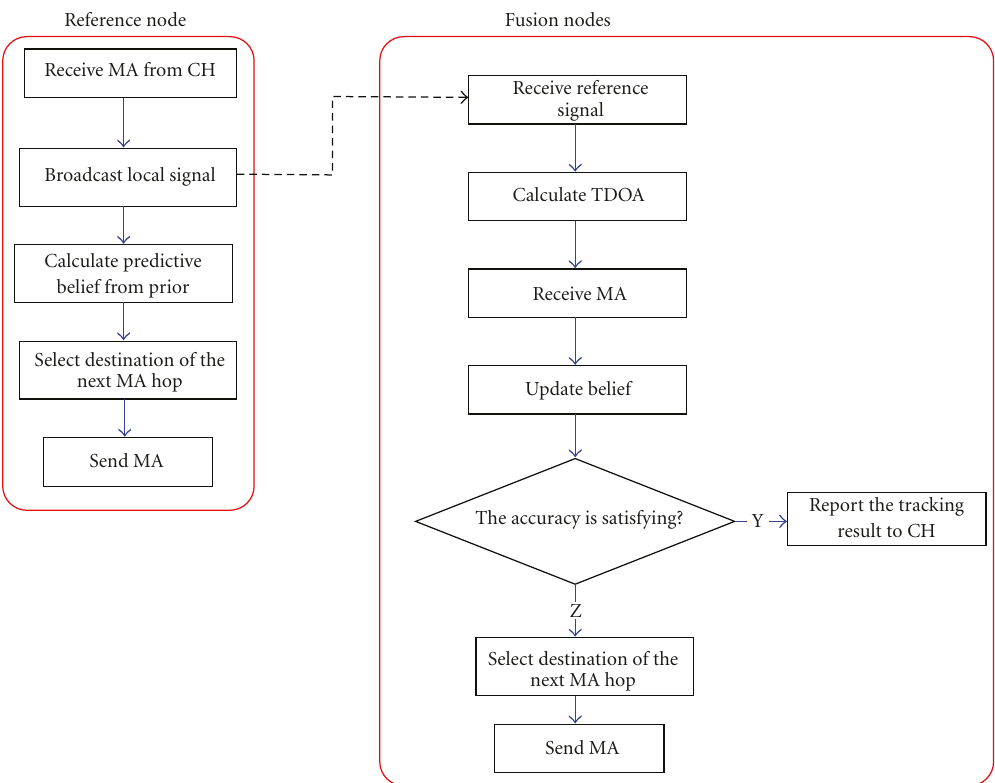
Figure 3: The working flowchart of distributed sequential Bayesian estimation for target